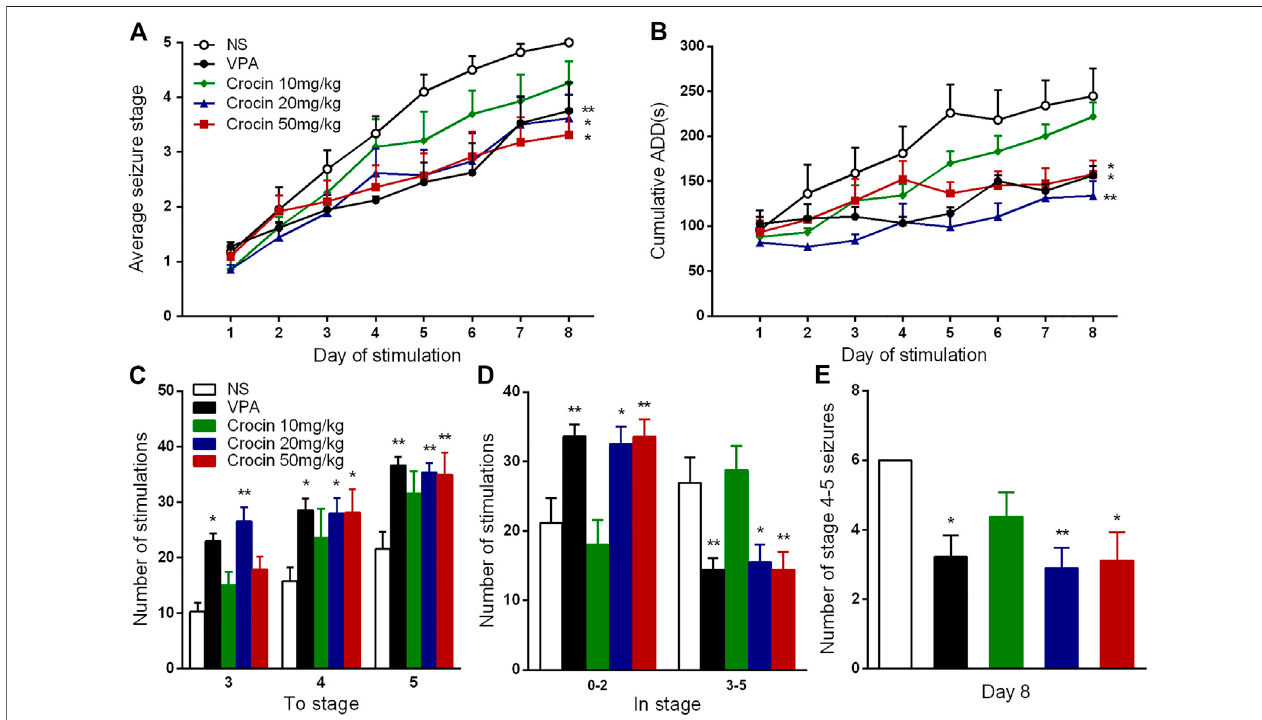
FIGURE 2 | Effects of crocin on hippocampal rapid kindling acquisition ( n = 8 for each group, x (cid:1) ±S.E.M.). (A) Average seizure stage; (B) cumulative ADD of six stimulations each day; (C) the number of stimulations to reach seizure stage 3, 4, 5; (D) the number of stimulations to stay in seizure stage 0 – 2 and 3 – 5 during kindling acquisition; (E) Number of stage 4 – 5 seizures in the 8th day. ADD, afterdischarge duration; NS, normal saline; VPA, sodium valproate. Values are from 3 independent experiments. * p < 0.05, ** p < 0.01, compared with NS group. Two-way ANOVA was performed for (A,B) . Comparisons of the number of stimulations for each seizure stage (C,D) were made with the nonparametric Mann – Whitney U test. One-way ANOVA for repeated measures was used followed by Tukey ’ s t-test for (E) .